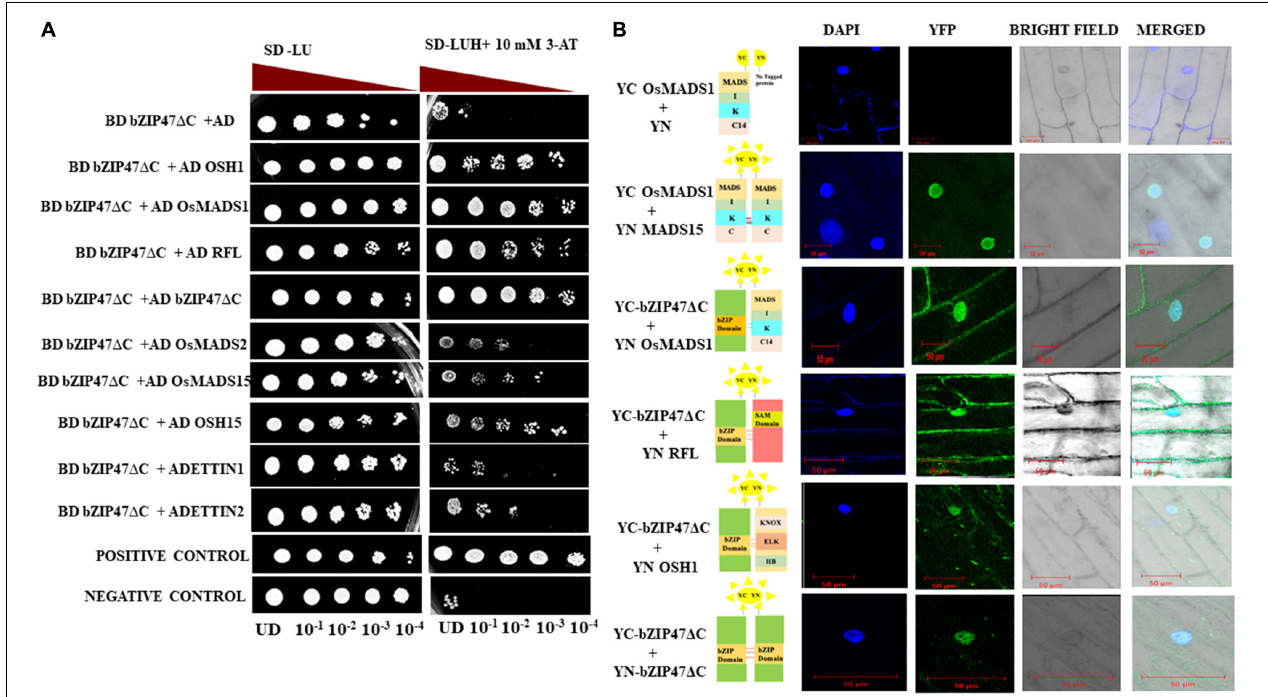
FIGURE 5 | Interaction of OsbZIP47 with other meristem factors. (A) Yeast two hybrid (Y2H) assays with OsbZIP47 (cid:49) C protein (lacking 186–380 amino acids in C terminal) and predicted protein partners, such as OsMADS1 (MIKC14 domain), RFL, OsETTIN1, OsETTIN2, OSH1, OsMADS2, OsMADS15, and OSH15. Serial dilutions of yeast cells (PJ694A) spotted on media lacking histidine and supplemented with 10 mM 3-AT. Growth after five days at 30 ◦ C is shown. Yeast transformants with OsMADS15 in pGBDUC1 vector and OsMADS1 MIKC14 in pGADC1vector served as positive control for protein interaction. A combination of pGADC1 and pGBDUC1 empty vectors (without protein fusion) was the negative control. (B) Validation of Y2H protein interactions by Bimolecular Fluorescence Complementation (BiFC) assays in onion epidermal cells. YFP fluorescence was detected when OsbZIP47 (cid:49) C-cYFP fusion protein was co-expressed with OsMADS1-nYFP, RFL-nYFP, and OSH1 nYFP. Absence of YFP fluorescence in the negative control i.e., OsbZIP47 (cid:49) CYC and YN domain alone was the negative control. Bars = 50 µ